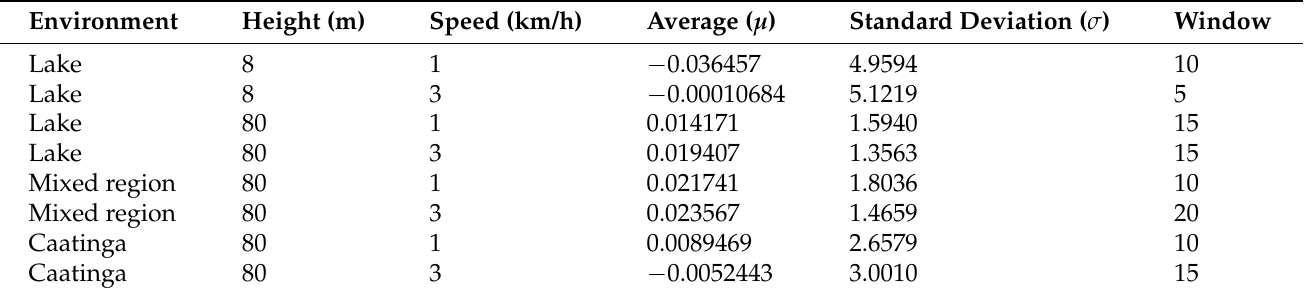
Table 7. Shadowing parameters for different